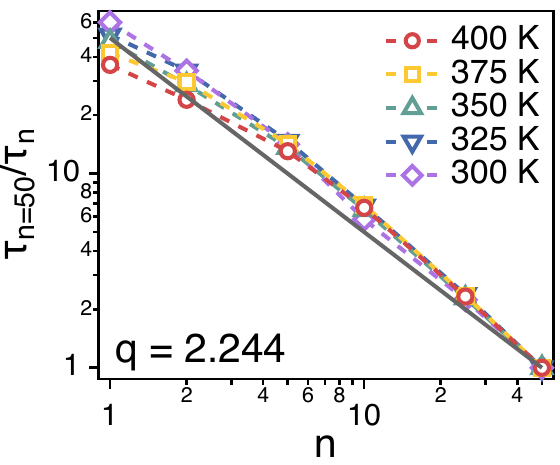
Figure 7. Simulation results for the relative relaxation times ( τ n of spatiotemporal correlations of strands of size n . The solid line is a guide line of τ n = 50 / τ n ∼ n − 1 .